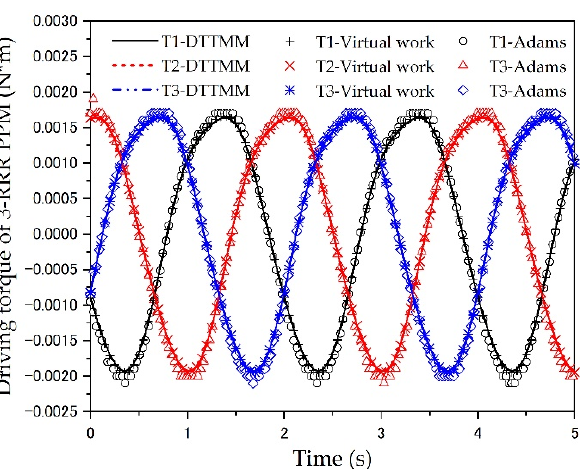
Figure 8. Driving torque of the 3-RPR PPM. Table 2 shows the root mean square errors between the different methods of three PPMs, compared with the two methods of DT-TMM and ADAMS simulation, the root mean square error values for all three driving forces are only 0.0002 (3-RRR), 0.0015 (3- PRR) and 0.0003 (3-RPR); the calculated order of magnitude is smaller, which means that the two methods agree very well with each other. All the root mean square error values of the DT-TMM model and the virtual work principle model are 0, which means that the